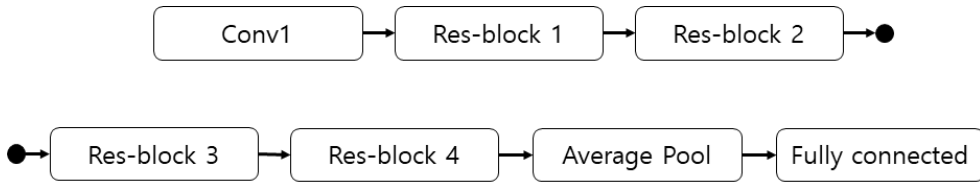
Figure 5. Structure of R3D-18.